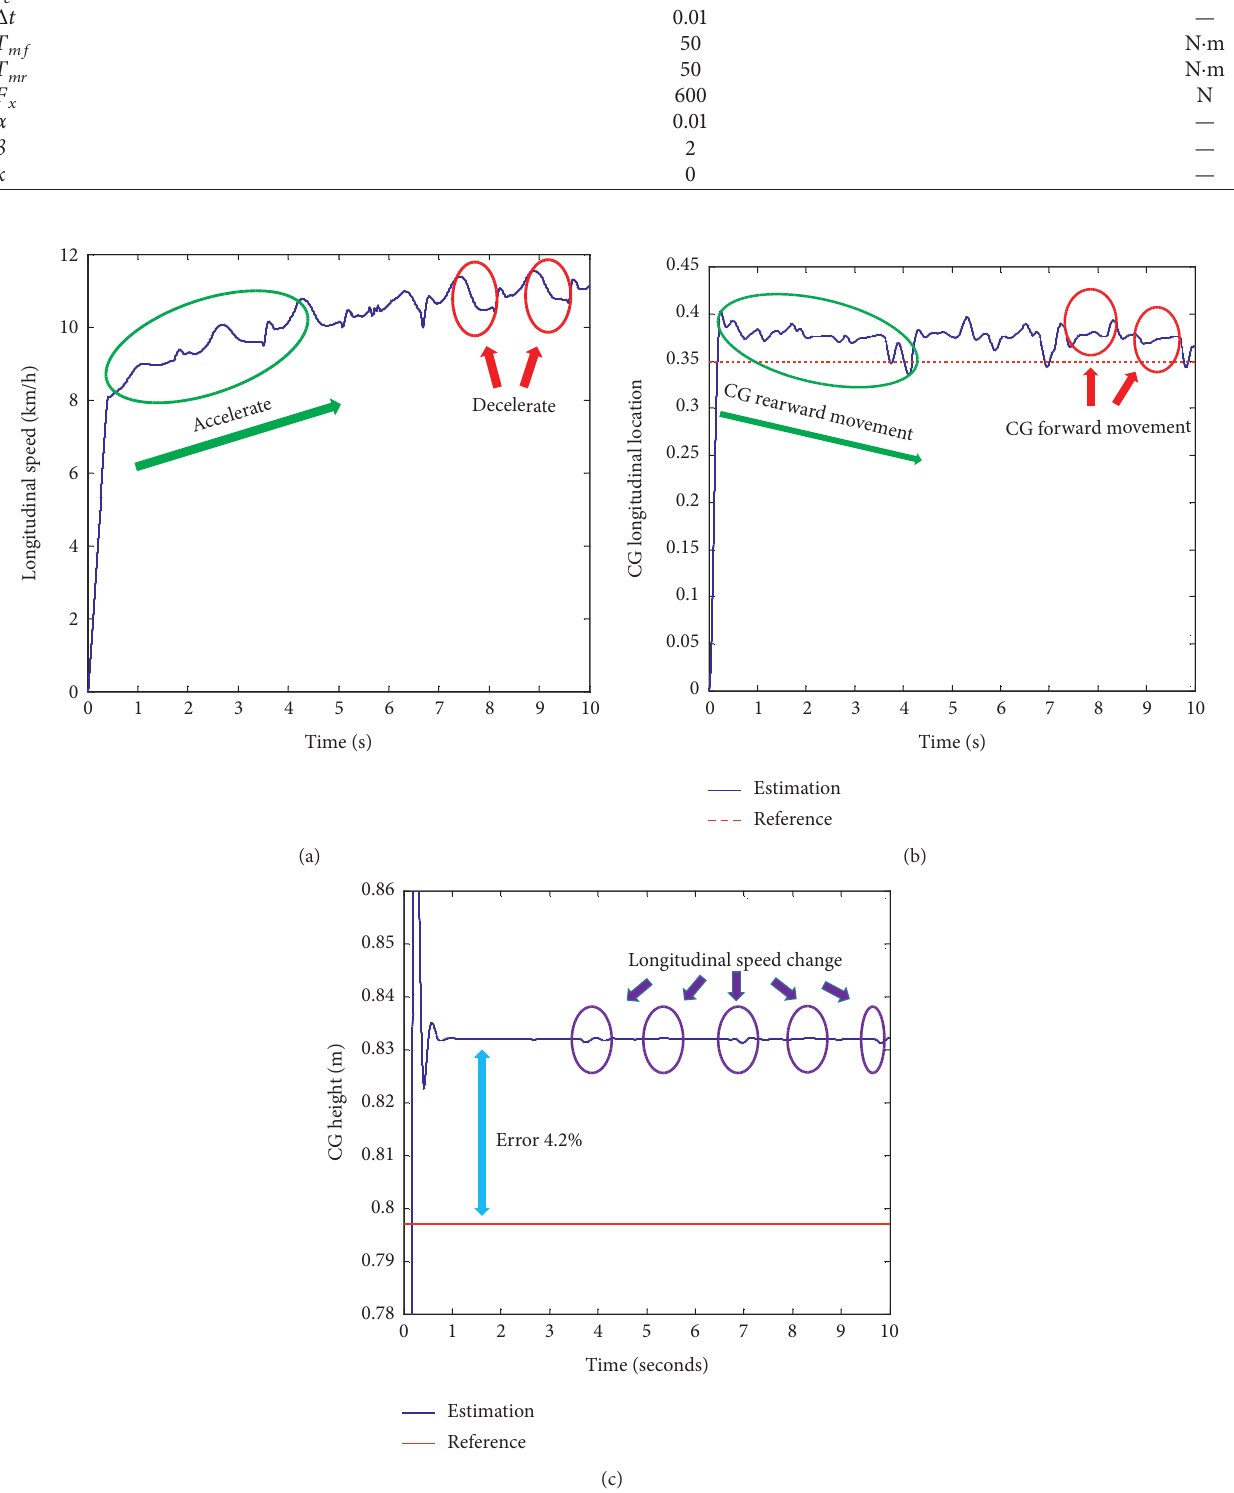
Figure 4: Simulation results for driving conditions on a bumpy road. (a) Longitudinal speed. (b) CG longitudinal location. (c) CG height.